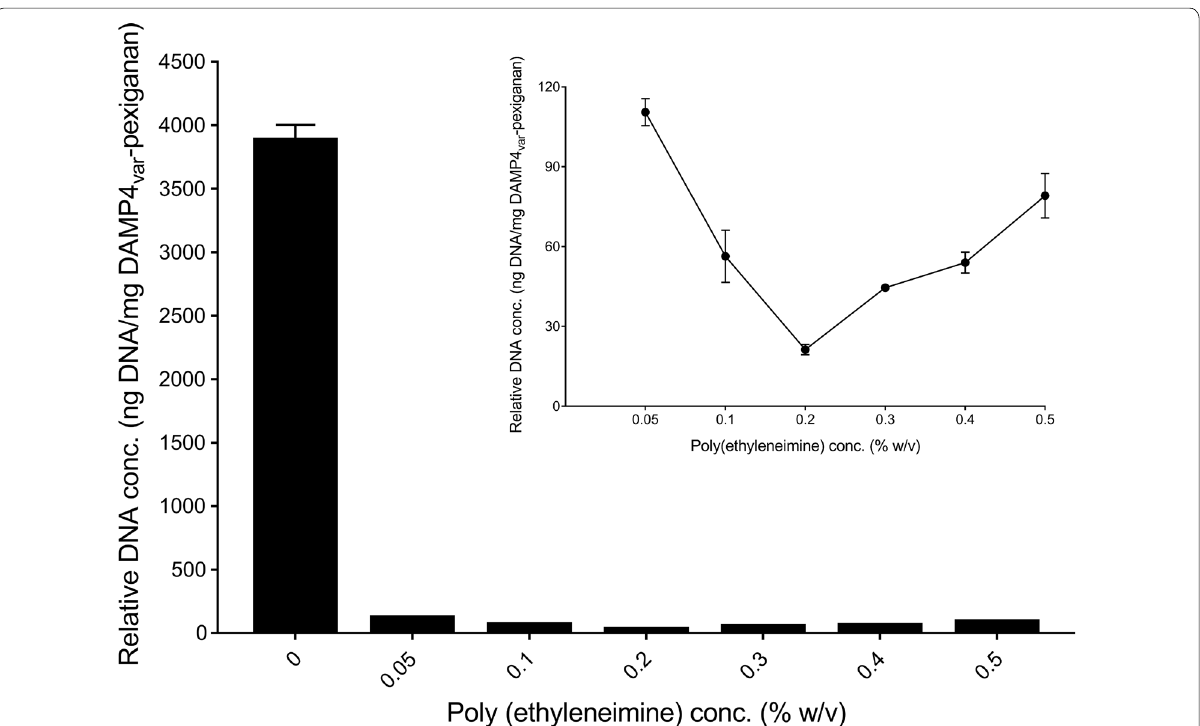
Fig. 2 Effect of poly(ethyleneimine) (PEI) concentrations (0.05–0.5% (w/v)) on the DNA precipitation in Tris–HCl buffer (25 mM, pH 8) containing 1 M